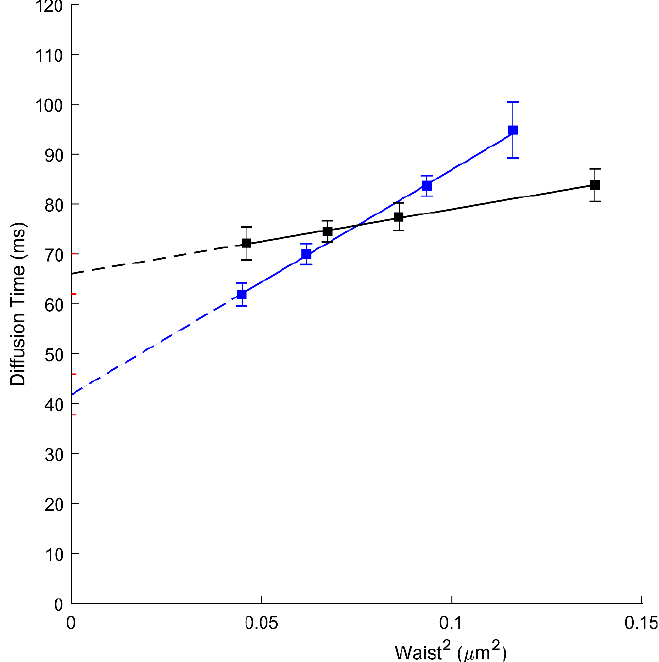
Figure 2. svFCS diffusion laws for an active ABCA1 in non-treated A1G cells (black) and after ApoA1 binding (blue).